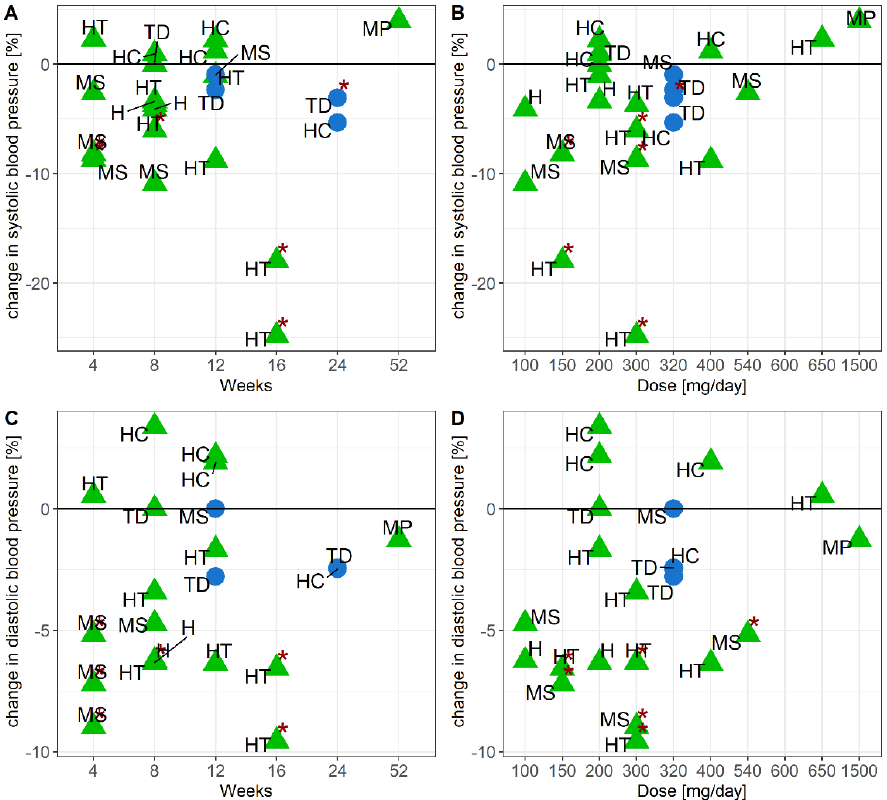
Figure 6. Relationship between systolic blood pressure and study duration ( A ), or dose ( B ), dias- tolic blood pressure and study duration ( C ) or dose ( D ). ● = bilberry and blackcurrant extract (blue), ▲ = grape seed extract (green), study population: H = healthy, HC = hypercholesterolemia, HT = hypertension, MP = mixed postmenopausal, MS = metabolic syndrome, TD = Type 2 Diabetes Mellitus. * published p -value < 0.05.